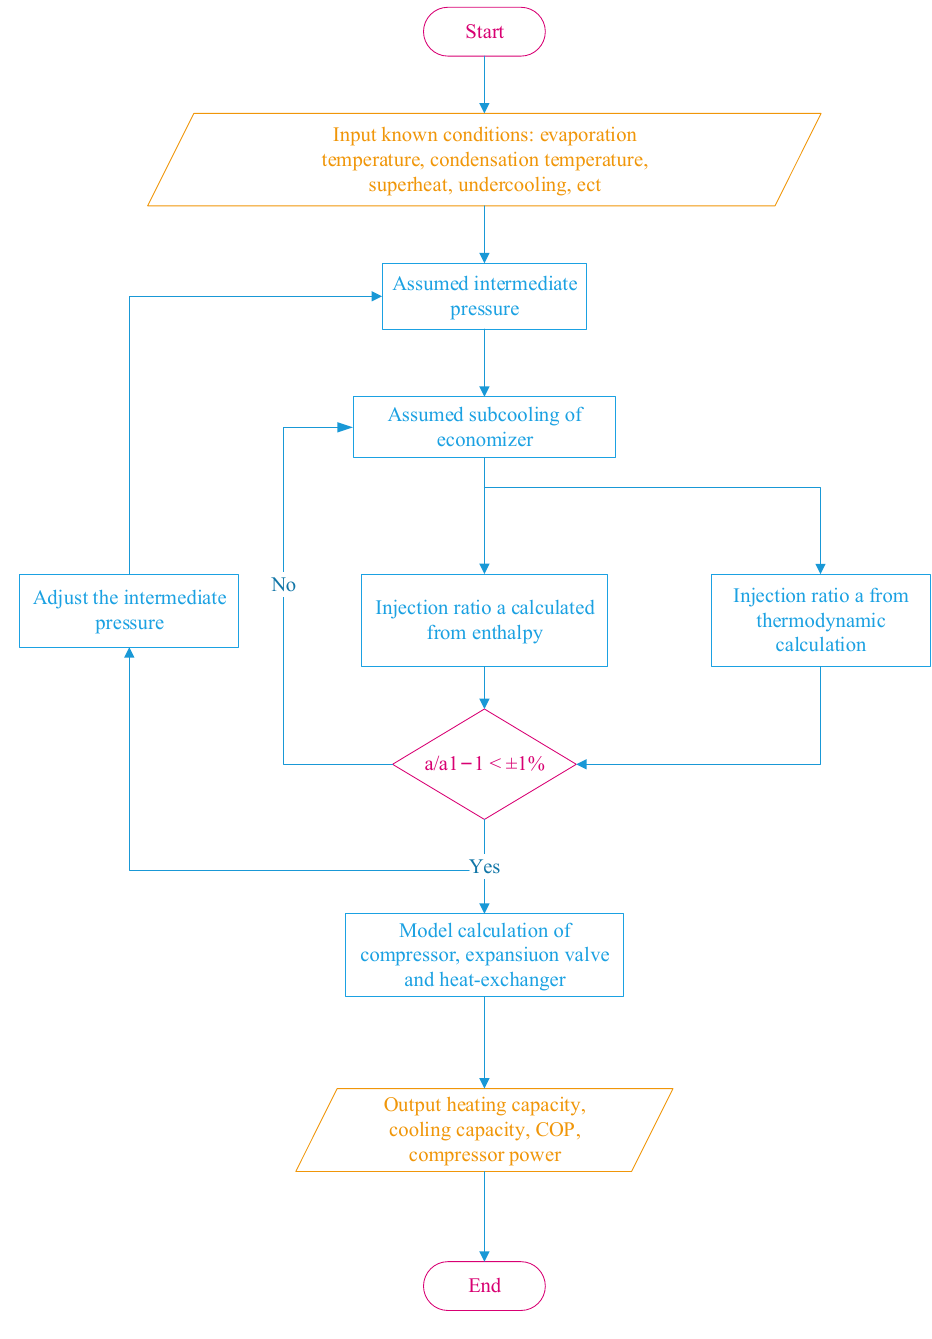
Figure 4. Algorithm flow chart of the influence of vapor-injection charge on the performance of heat-pump drying system.